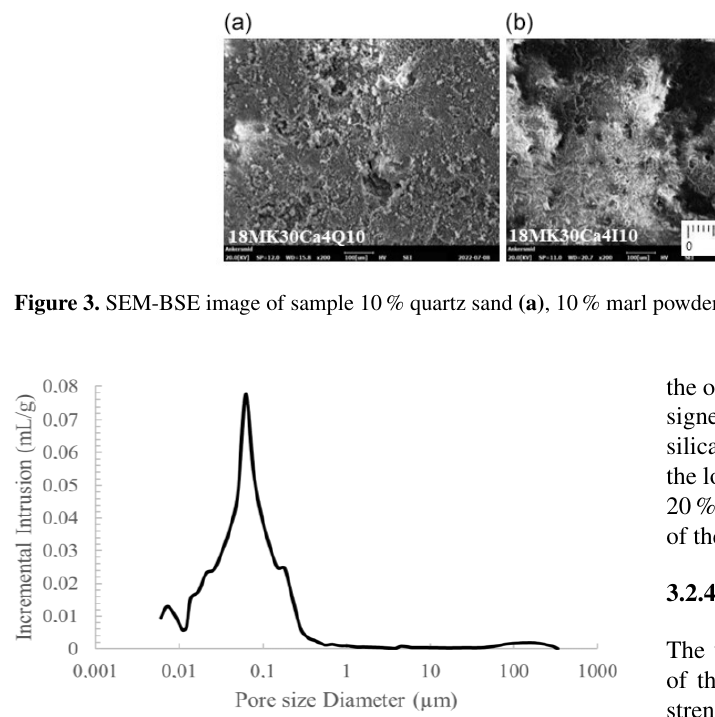
Figure 4. Pore size distribution of sample 30Ca4 , showing a uni- modal pore size distributed just below